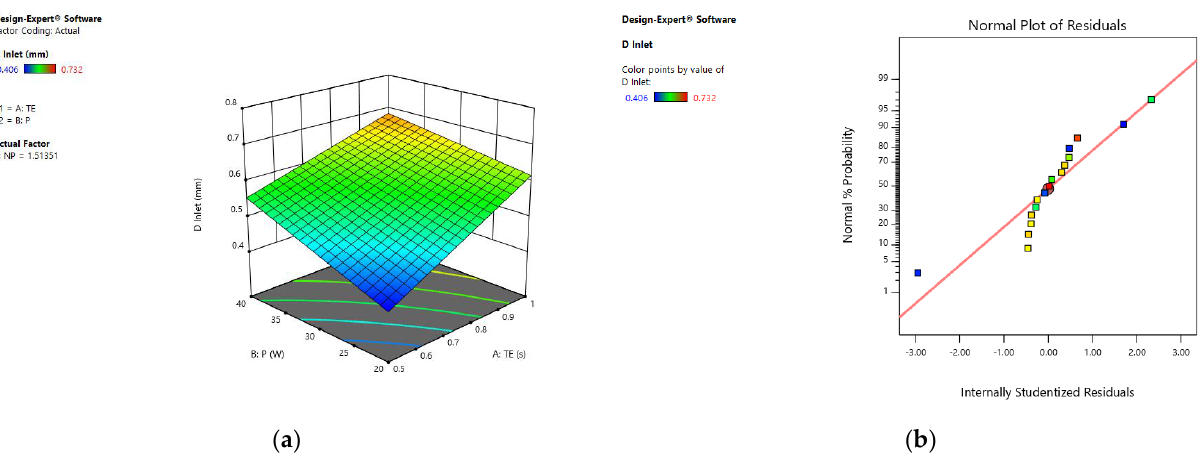
Figure 13. ANOVA model results for D INLET at 0.1 wt.% CNPs: ( a ) 3D response surface and ( b ) normal residuals